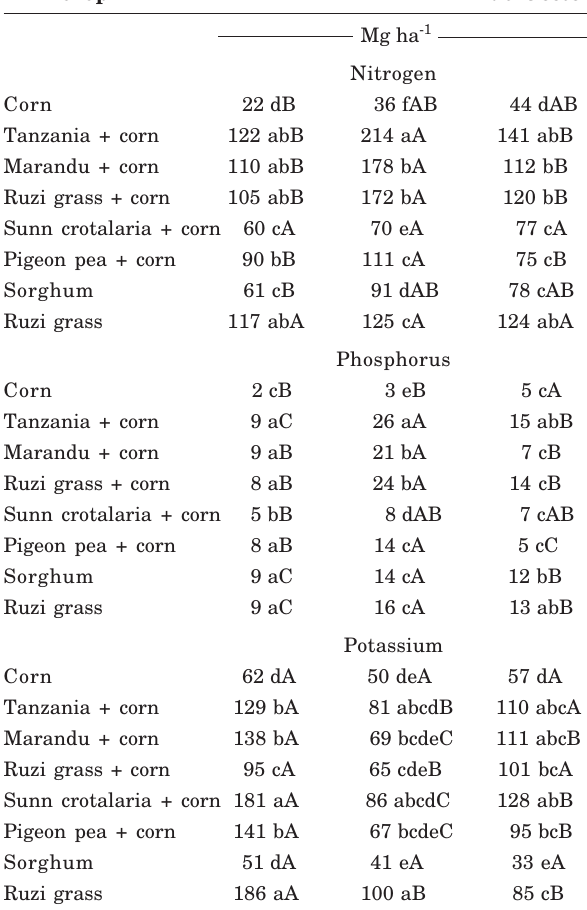
Table 4. Amount of nitrogen, phosphorus and potassium in stover before soybean planting in October 2005 in Mato Grosso do Sul,